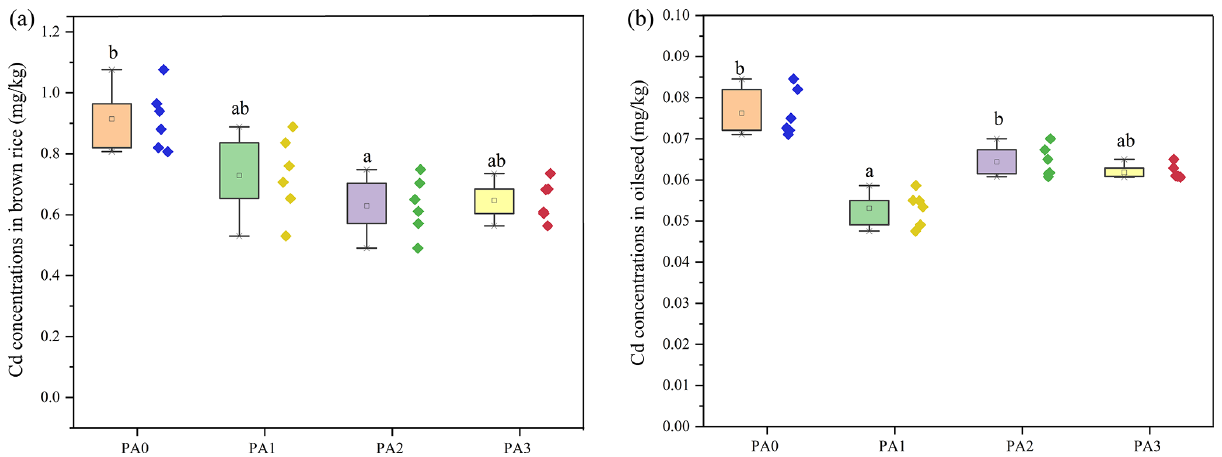
Figure 3. The effects of the amendments on the Cd concentrations in brown rice (a) and oilseed (b) . Dots represent the value of each sample. Bars with different lowercase letters indicate the significant ( p< 0 . 05) difference among different treatments according to the LSD test. Values represent means ± standard deviation.